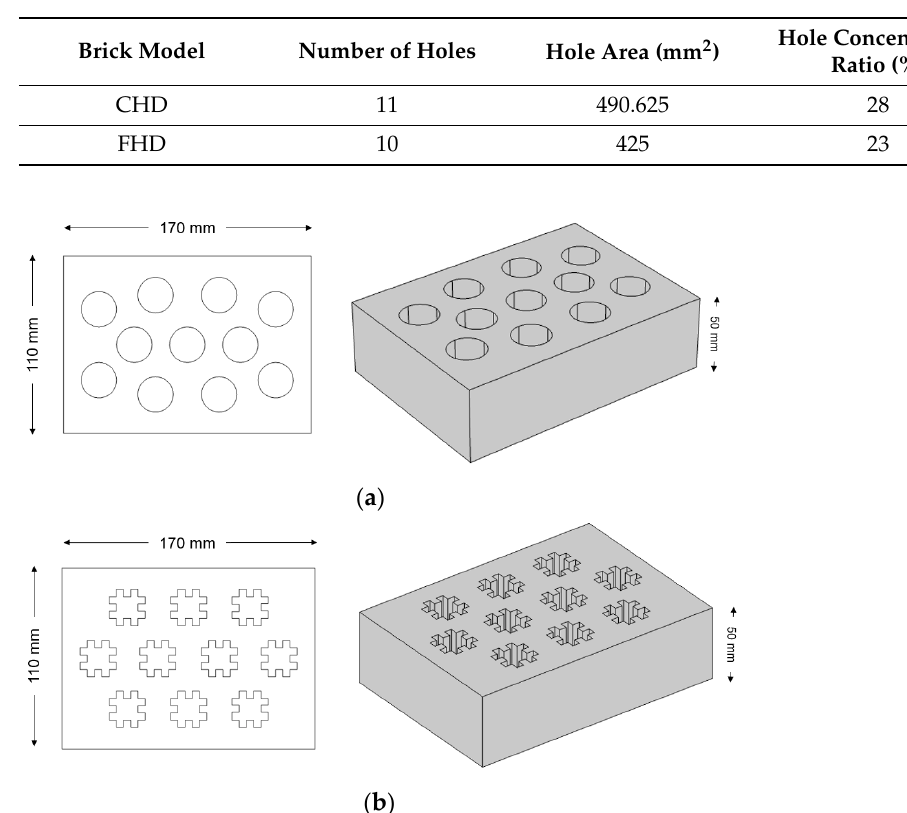
Figure 5. Hollow brick models: ( a ) CHD and ( b ) FHD.